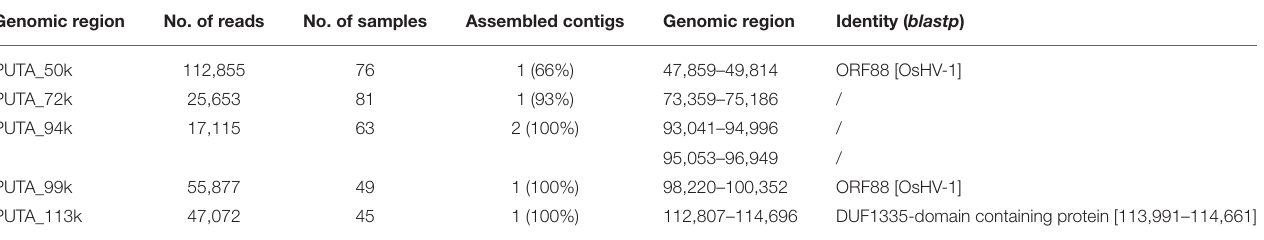
TABLE 7 | De-novo assembly results of reads mapping on OsHV-1 putative coding regions. Genomic